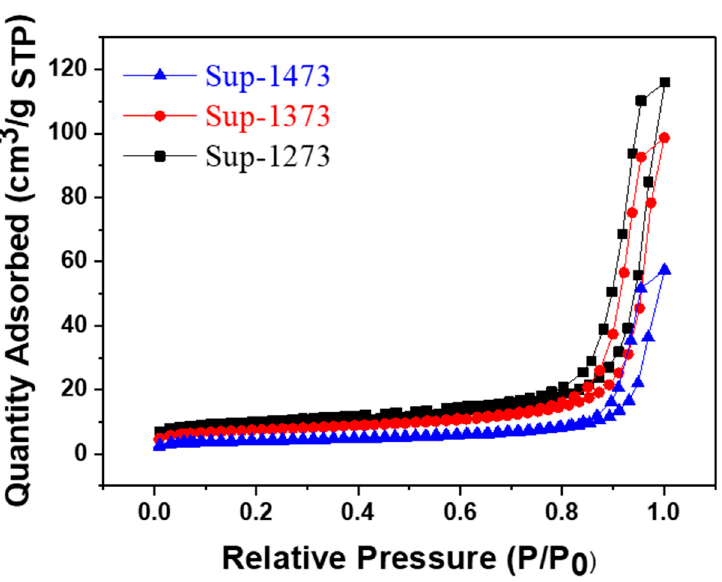
Figure 3. N 2 adsorption–desorption isotherms of each MgAl 2 O 4 pellet. Table 1. Porosity of the MgAl 2 O 4 pellet supports obtained by N 2 adsorption and desorption analysis. Pellet Supports Surface Area (m 2 /g)